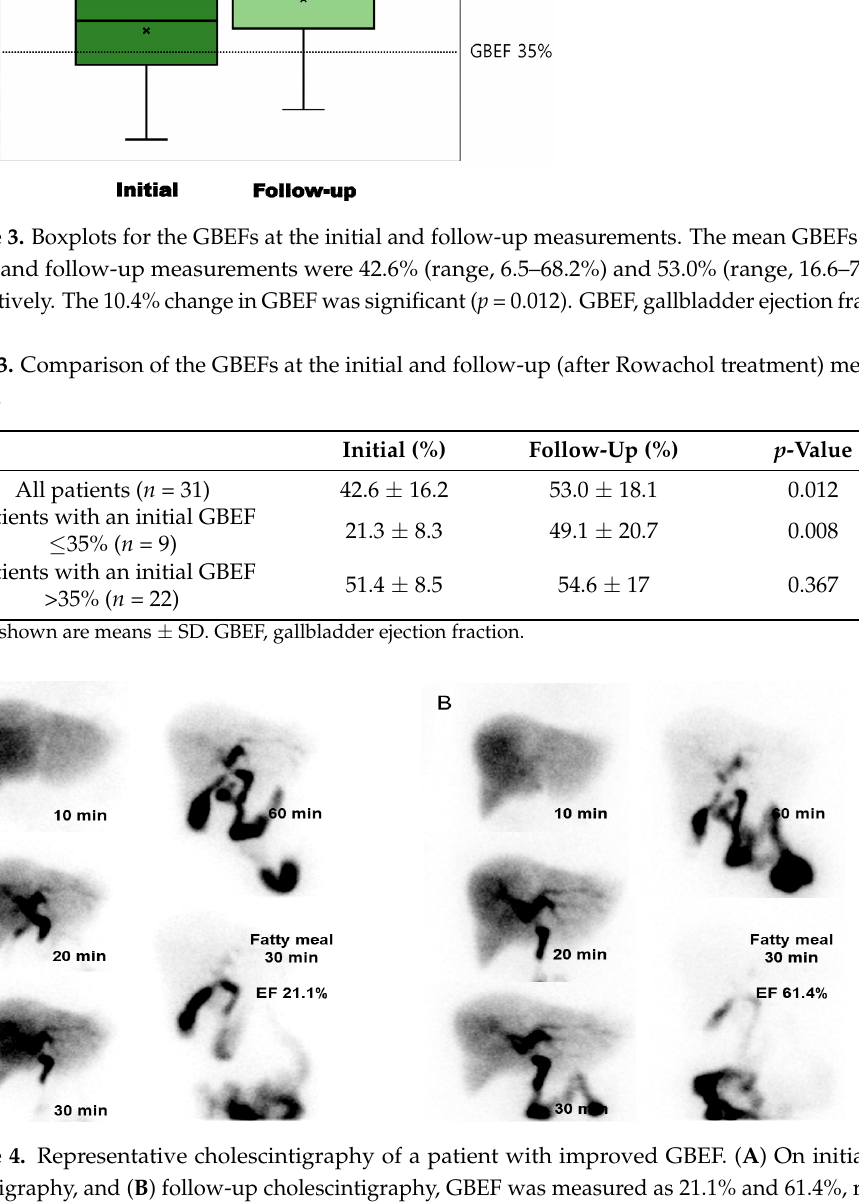
Figure 4. Representative cholescintigraphy of a patient with improved GBEF. ( A ) On initial cholescintigraphy, and ( B ) follow-up cholescintigraphy, GBEF was measured as 21.1% and 61.4%, respectively. GBEF, gallbladder ejection fraction. Table 3. Comparison of the GBEFs at the initial and follow-up (after Rowachol treatment) measurements.